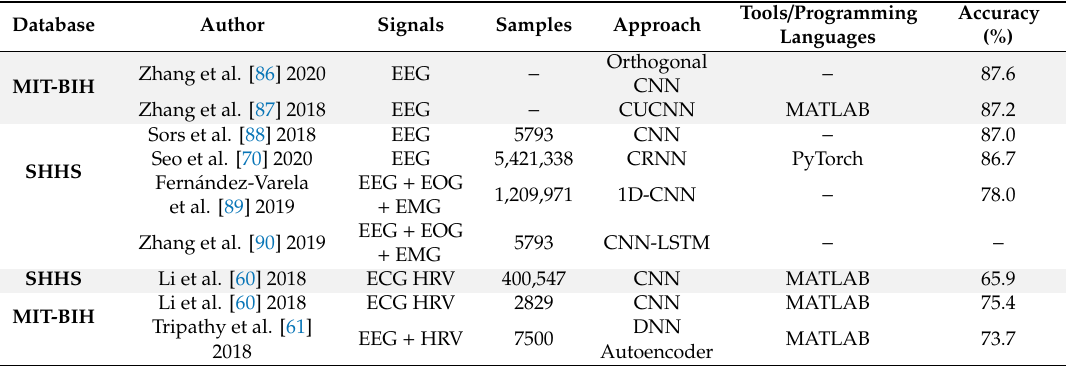
Table 4. Summary of automated sleep stage classification approaches with DL applied to PSG recordings in Sleep Heart Health Study (SHHS) and Massachusetts Institute of Technology-Beth Israel Hospital (MIT-BIH)